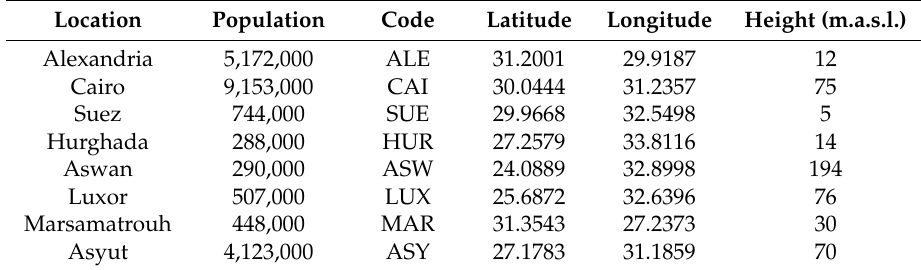
Table 1. Coordinates (degrees), population and average height (meters above sea level) of the specific locations in Egypt. Location Population Code Latitude Longitude Height